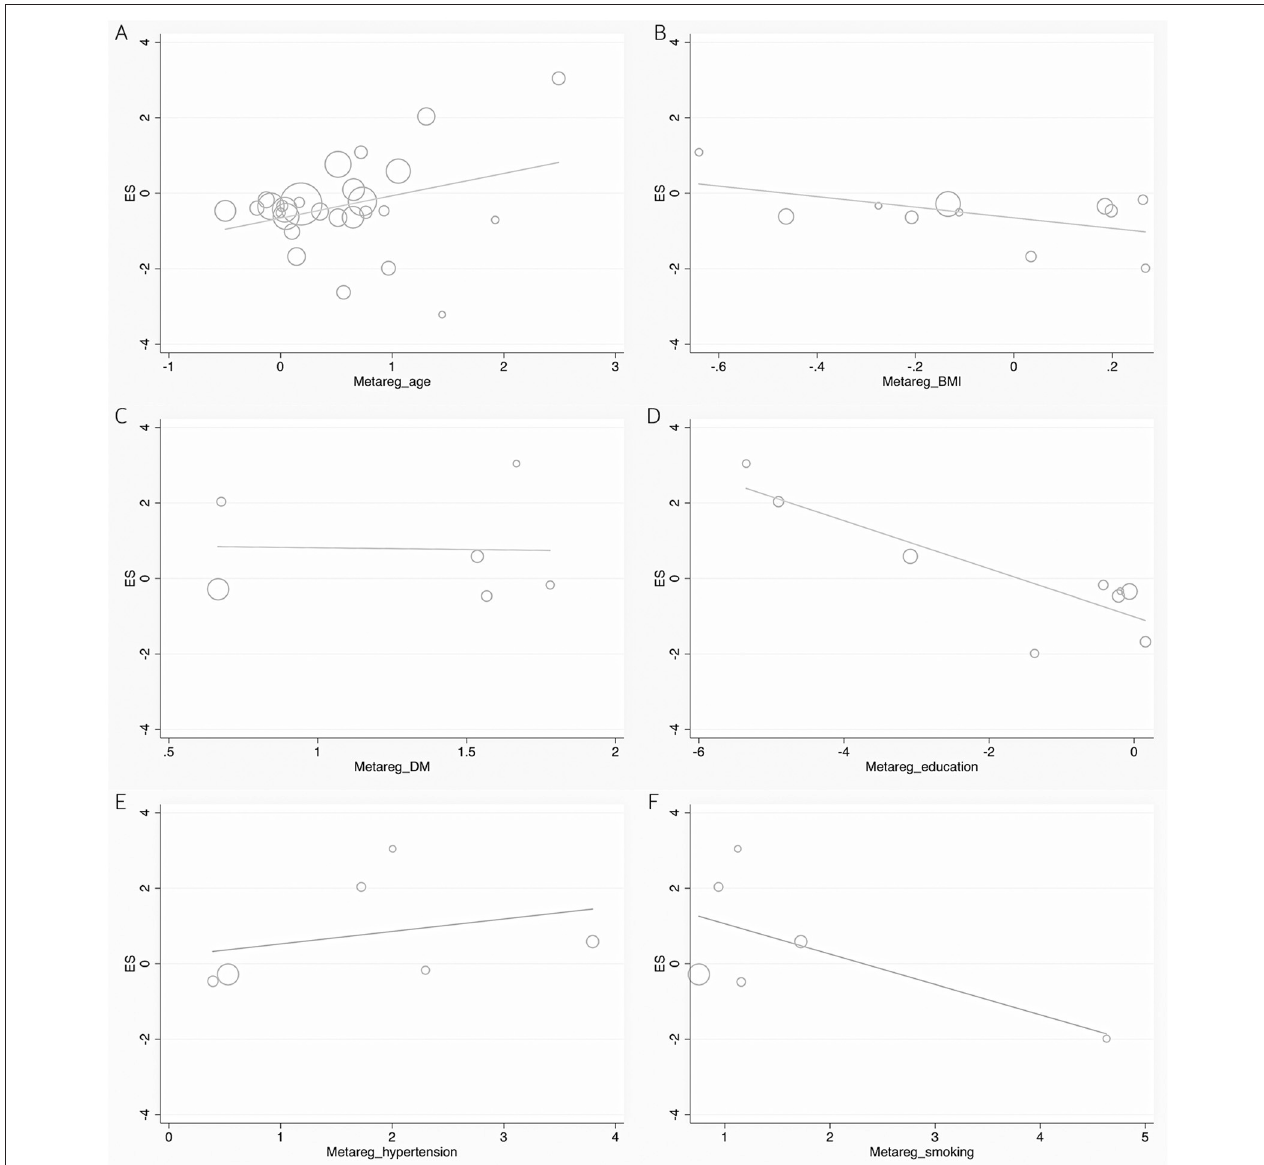
FIGURE 6 | Forest plots of the meta-regression analyses on age (A) , BMI (B) , DM (C) , education (D) , hypertension (E) , and smoking (F) in UA between dementia and non-dementia. BMI, body mass index; DM, diabetes mellitus; ES, effect size; UA, uric